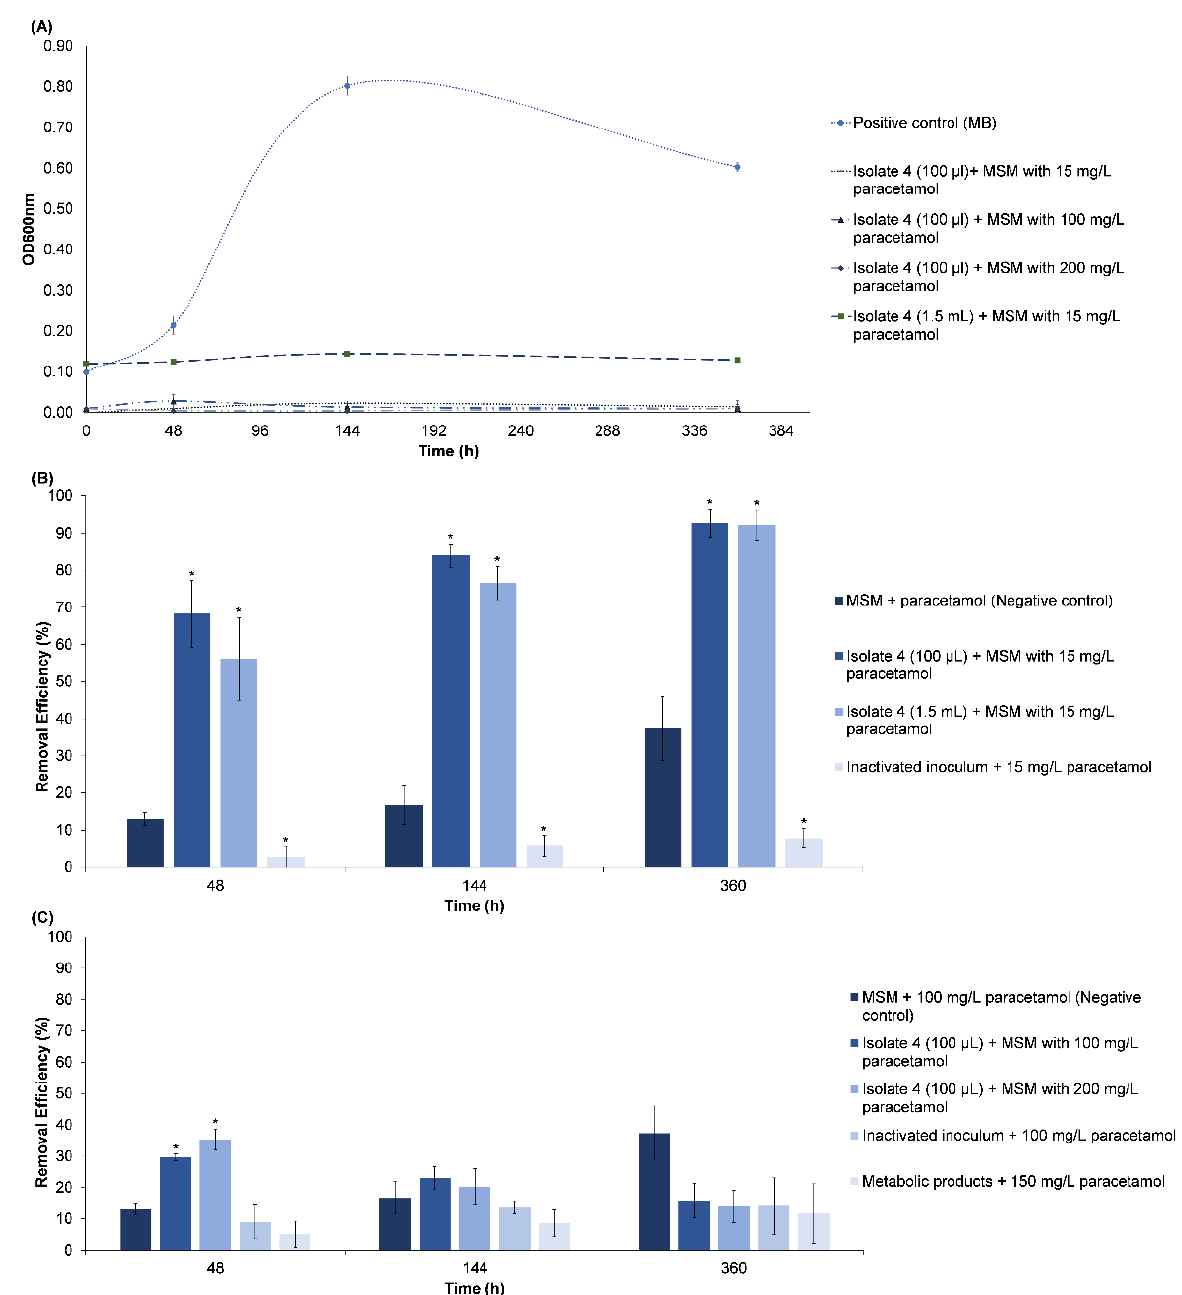
Figure 3. Representation of bacterial growth curve ( A ), removal efficiency in percentage in isolate 4 cultures in the presence of 15 mg/L ( B ), 100 mg/L and 200 mg/L of paracetamol ( C ) and the drug with inactivated sludge and extracellular metabolic products ( C ) over 360 h (15 days) of assay. Asterisks indicate a significant difference compared to the control at p < 0.05 *. Values are expressed as the mean ± standard error (n =